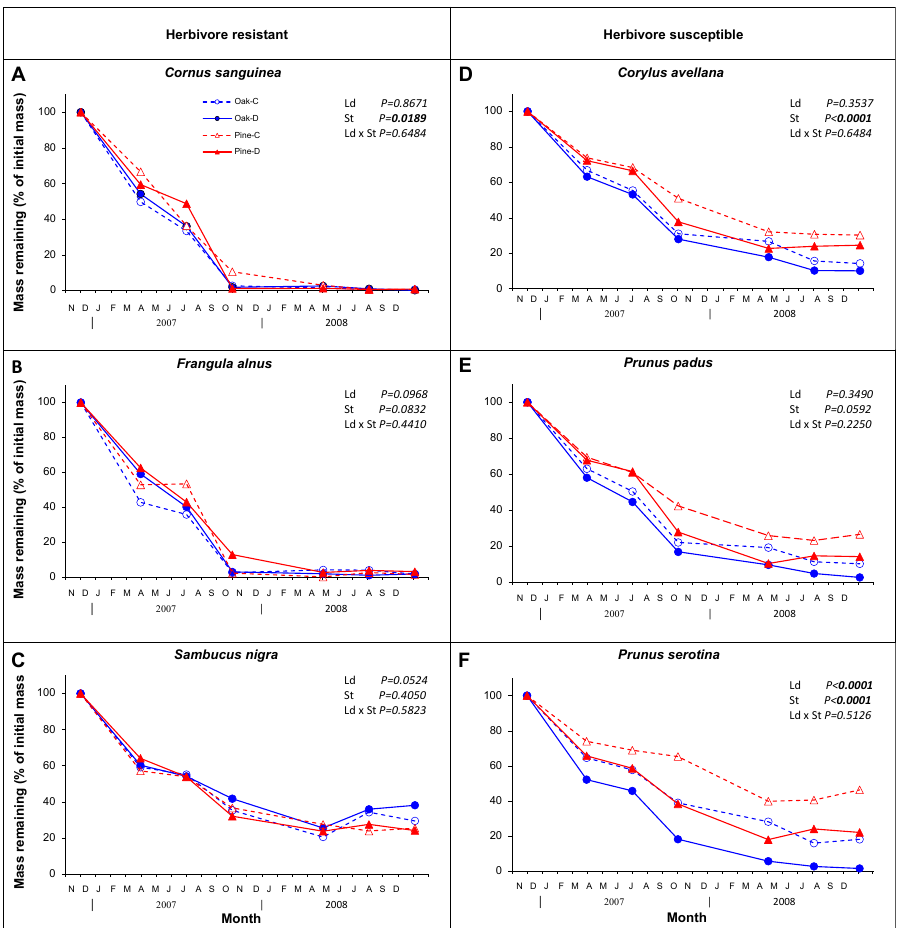
Figure 2. Dynamics of leaf litter decomposition of six understory plant species (herbivore resistant species: Cornus sanguinea —( A ), Frangula alnus —( B ), Sambucus nigra —( C ), on the left and herbivore susceptible species: Corylus avellana —( D ), Prunus padus —( E ), Prunus serotina —( F ), on the right), depending on leaf damage (Ld; control (C) and damaged (D)) in two stand species (St; oak and pine monocultures).